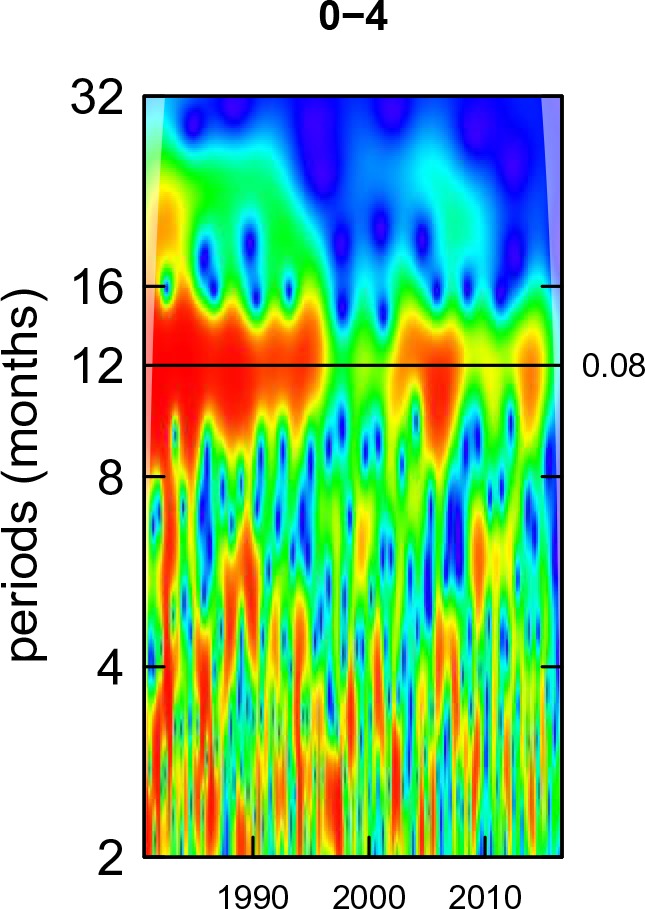
Wavelet power spectra for national time series of perinatal condition death rates for 1980–2016, by age group for males.Wavelet power values increase from blue to red. The shaded regions at the left and right edge of each box indicate the cone of influence, where spectral analysis is less robust. P-values for the presence of 12 month seasonality are to the right of each figure at the 12 month line.